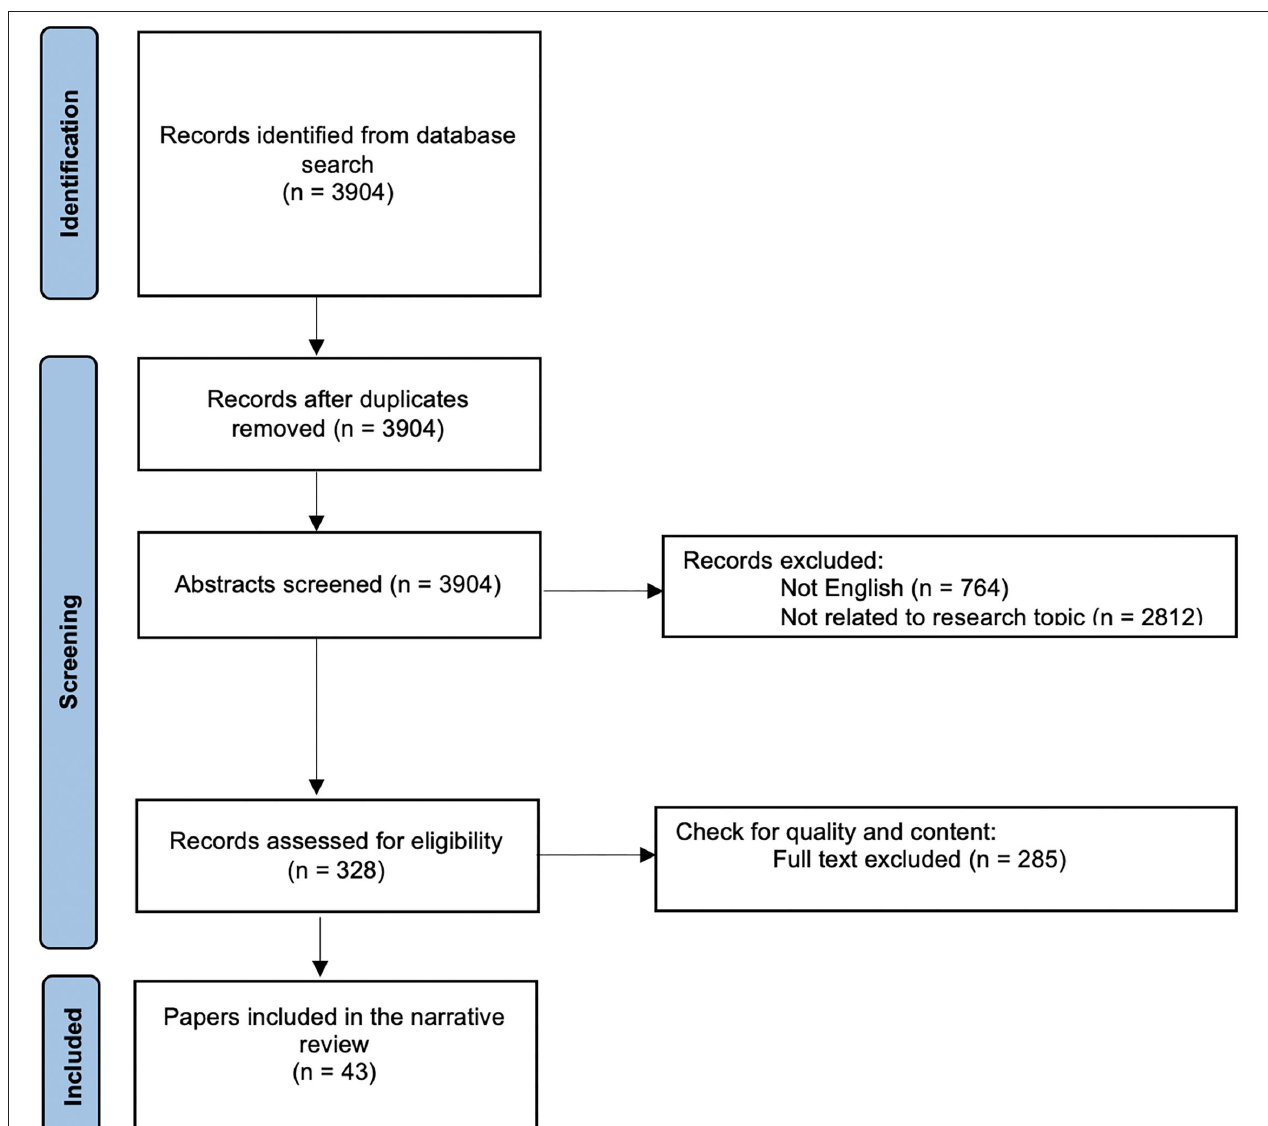
FIGURE 1 | Flow diagram describing the inclusion decision of papers under the scope of this